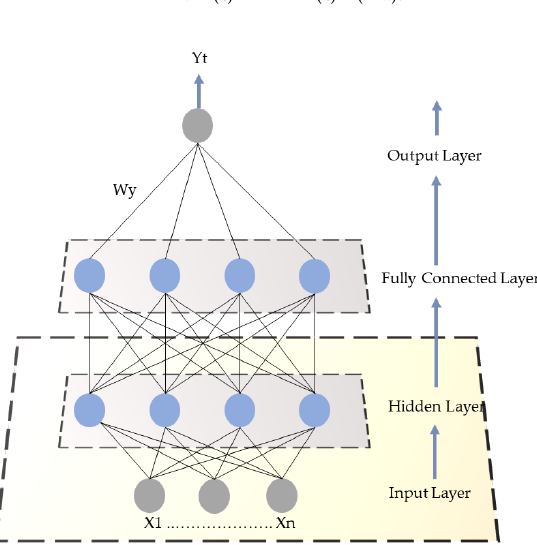
Figure 6. The GRU architecture for HL and CL prediction.